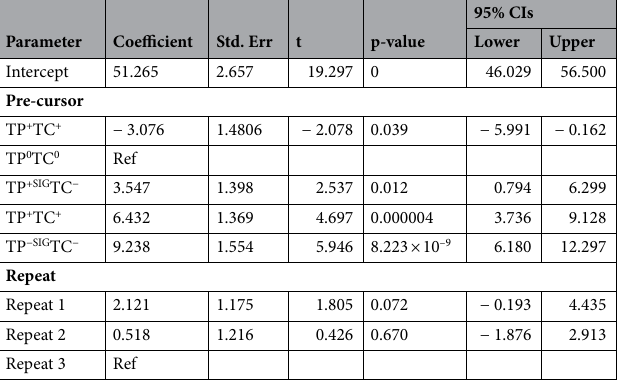
Table 2. Experiment 2: Fixed coefficients of the Generalized Linear Mixed Model (GLMM), including: estimate strength (Estimates), standard errors (Std. Errs), t-statistics (t), probability value (p-value) and 95% confidence intervals (Cis), for each fixed effect and the interaction bandwidth × predictability.